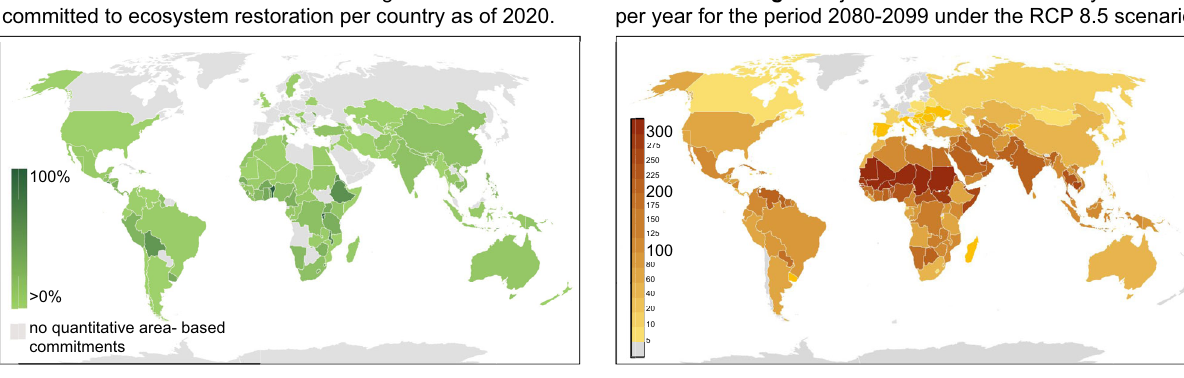
indicated by blue gradient. Fifteen countries with the highest material footprint in 2019 are marked with a yellow dot.